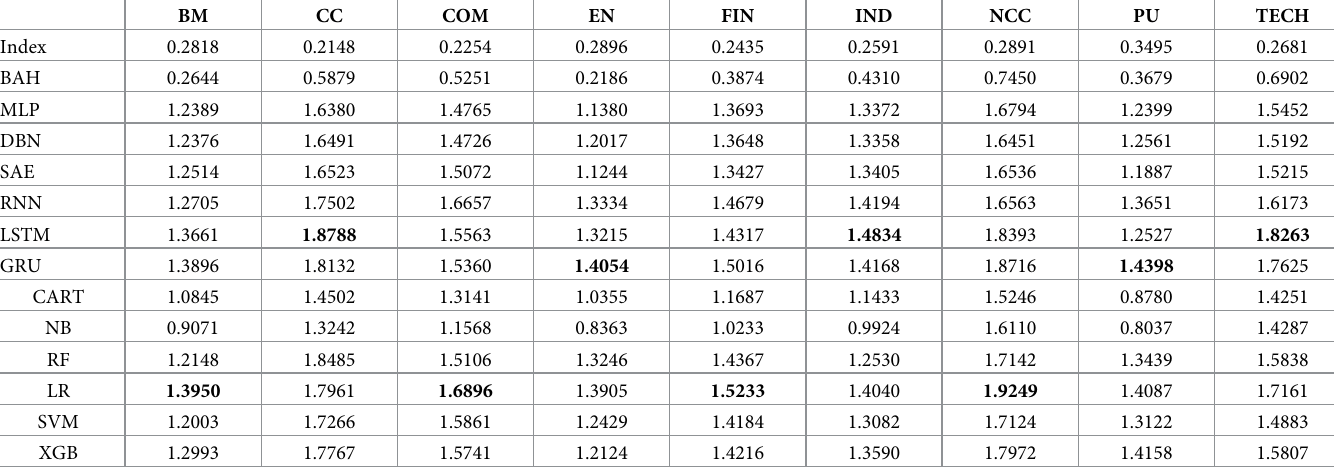
Table 10. Comparison of the ASR of various trading strategies in the different industries of CSICS. Best performance is in